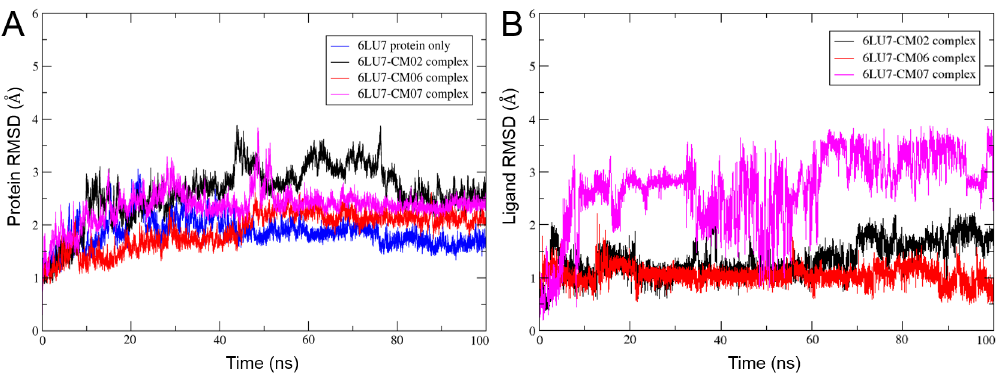
Figure 19. Root mean square deviation (RMSD) analysis of molecular dynamic (MD) simulation trajectory. The RMSD plot obtained for ( A ) C - α atoms of the protein SARS-CoV-2 M pro (PDB ID 6LU7) with CM02, CM06 and CM07 complex; and ( B ) ligand-heavy atoms for CM02, CM06 and CM07-SARS-CoV-2 M pro complex (PDB ID: 6LU7), with respect to the reference frame at time 0